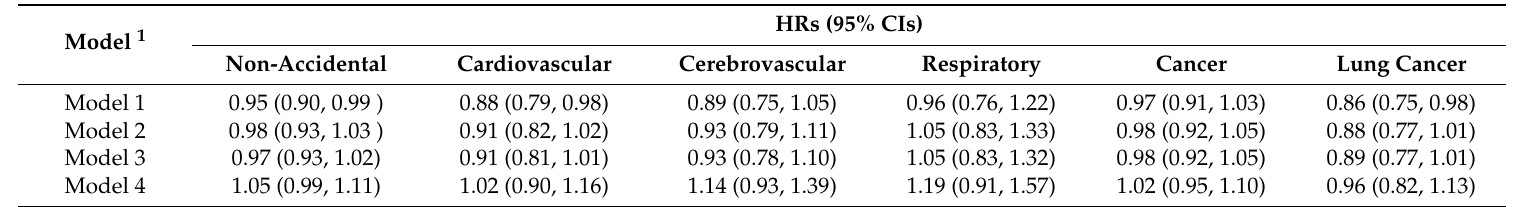
Table 2. Adjusted hazard ratios (HRs) and 95% confidence intervals (CIs) of non-accidental and cause-specific mortality for an increase of 10 µ g/m 3 in long-term PM